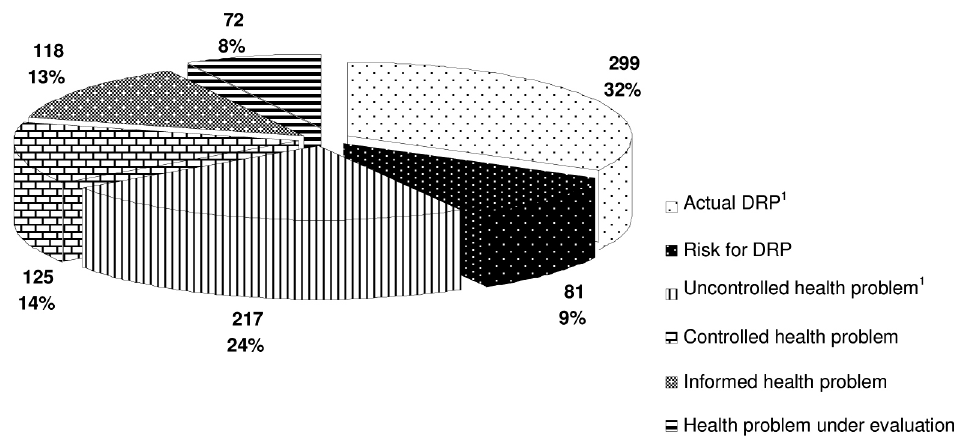
FIGURE 1 – Distribution of health problems, per category, presented by patients followed-up at FECUNP from 2001 to 2003. Note 1: Uncontrolled problems.